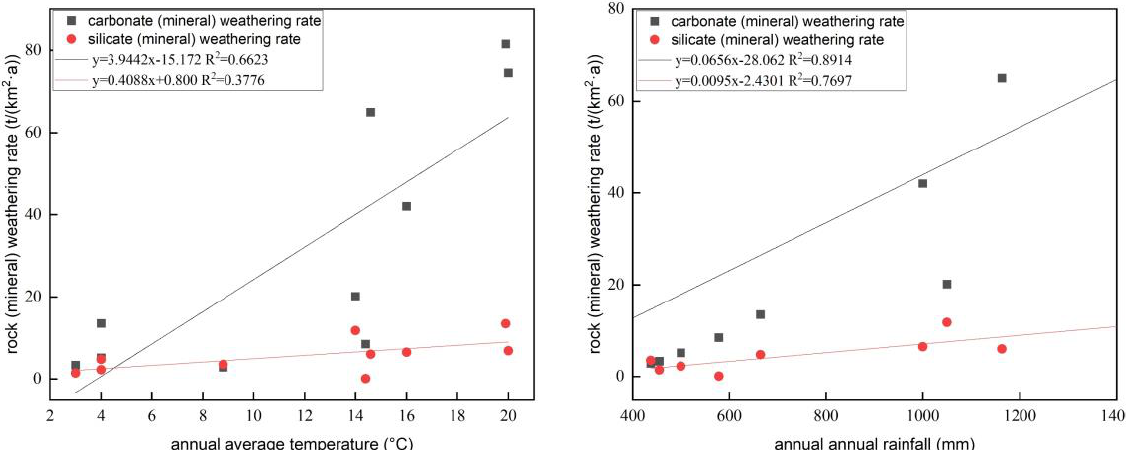
Figure 4. Relationship between rock (mineral) weathering rate, rainfall, and temperature.